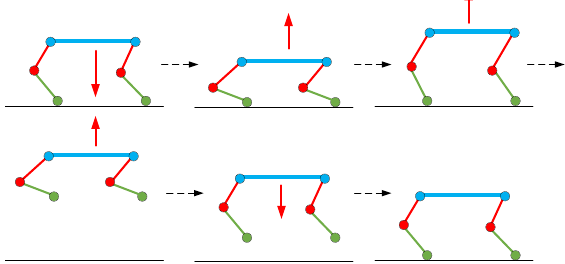
Figure 2. The vertical jump process of quadruped robots. The red arrow shows the tendency of the body to move in the vertical direction.